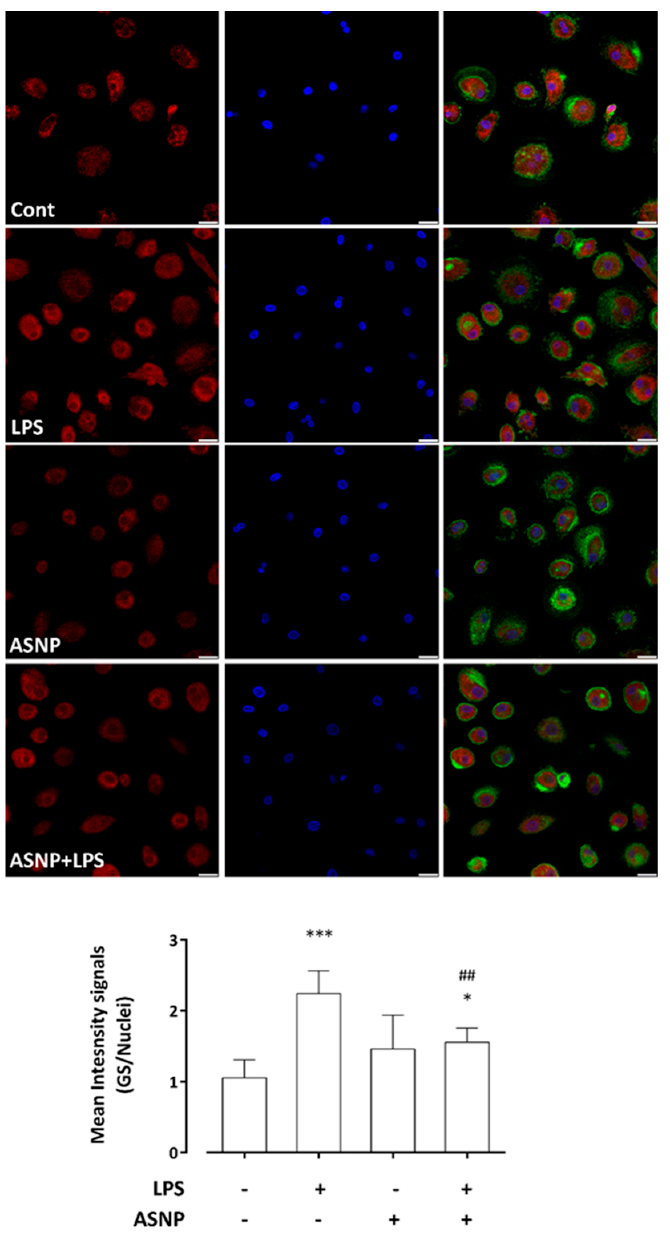
Figure 6. GS protein expression in human MDM exposed to ASNP. After the experimental treatments (ASNP, 48 h; LPS, the last 24 h of incubation), human macrophages were fixed and co − stained for GS (red) or actin (green), as described in Materials and Methods. Nuclei counterstaining is reported in blue. Images are representative fields of confocal single sections. Bars = 20 μ m. The results are the mean ± SD of GS/nuclei intensity signals, recorded on the acquired single sections (n = 8). * p < 0.05, *** p < 0.001 vs. Control; ## p < 0.01 vs. 1 ng/mL LPS, one − way ANOVA followed